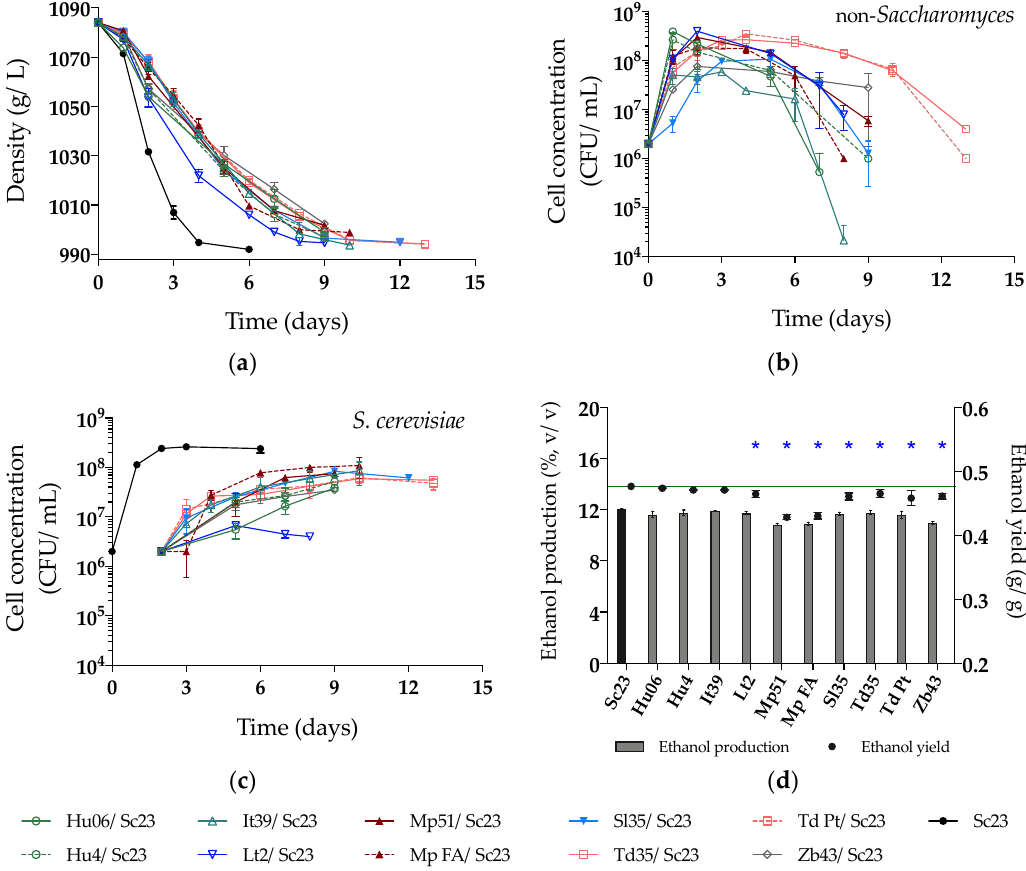
Figure 3. ( a ) Density (g / L); ( b ) Yeast population of non- Saccharomyces ; ( c ) Yeast population of Sc23 and ( d ) Ethanol production (%, v / v) and yield (g / g) during sequential fermentations in synthetic must. The value of the green line in Figure ( d ) is 0.48 g / g (ethanol yield of Sc23). Asterisks (*) show the significant difference of ethanol yield compared with Sc23 (LSD, p < 0.05).